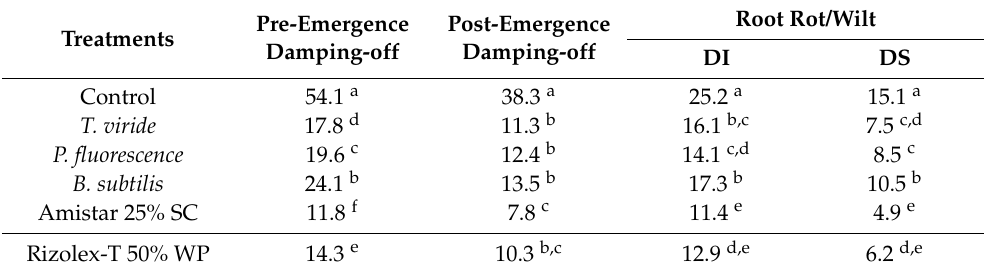
Table 2. Effect of different bioagent treatments on damping-off and root rot/wilt caused by Rhizoctonia solani